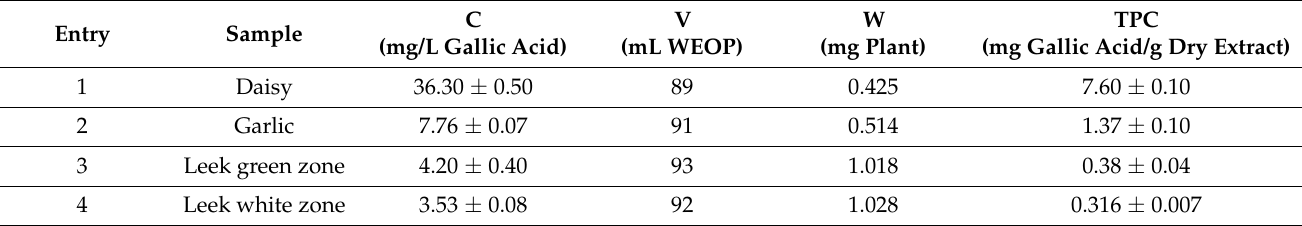
Table 2. Total phenolic content (TPC) of the different plant